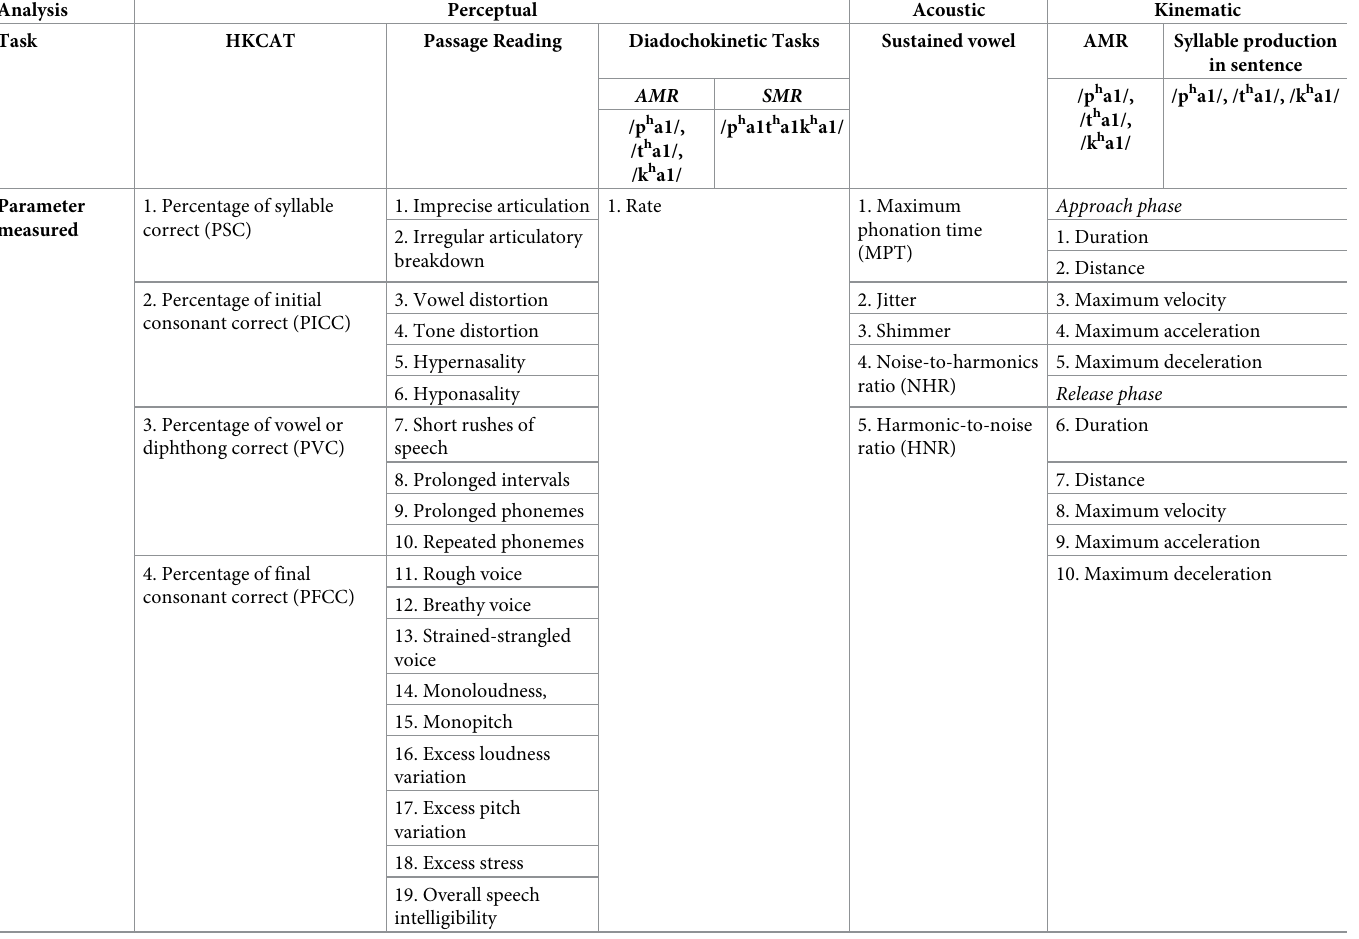
Table 2. Summary of outcome measures investigated in the stimulation and sham groups before and after treatment.